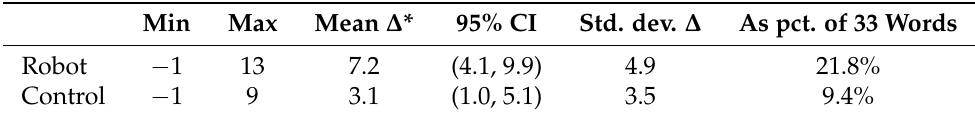
Table 3. Vocabulary scores per trial group. The 95% confidence interval (CI) was calculated using bootstrapping (* = p <